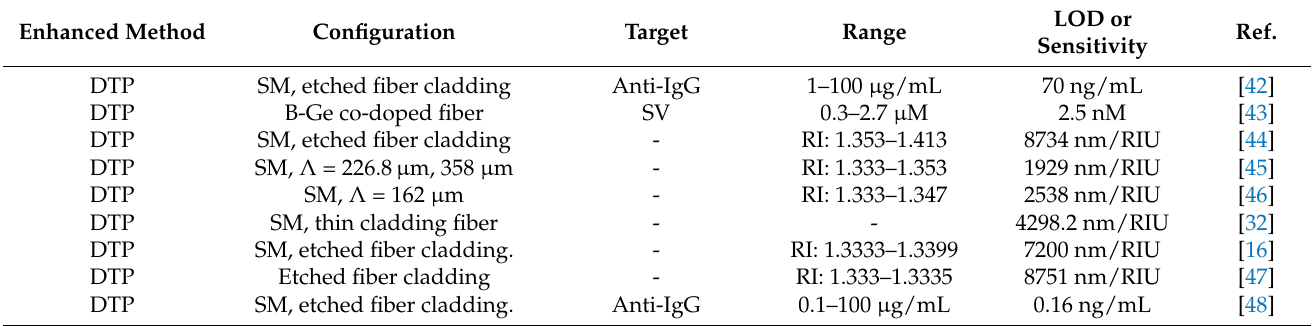
Table 1. Comparison different methods to enhance LPFG-based